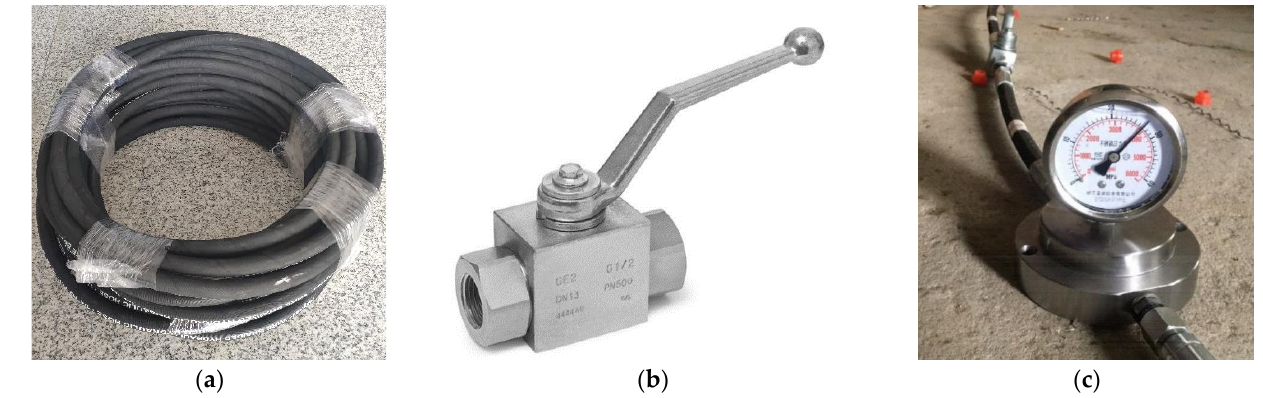
Figure 11. Load adjustment system connection fittings. ( a ) High-pressure oil pipe; ( b ) ball valves; ( c ) pressure gauges.